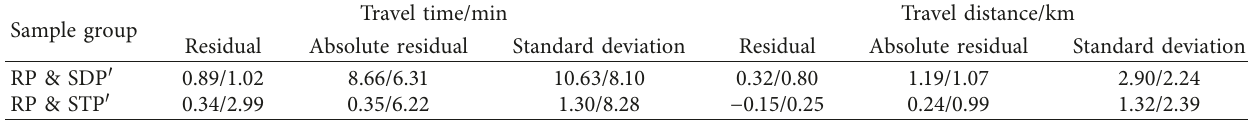
Table 11: The deviation between the actual and the shortest paths of the fixed/nonfixed OD trips on weekdays. Sample group